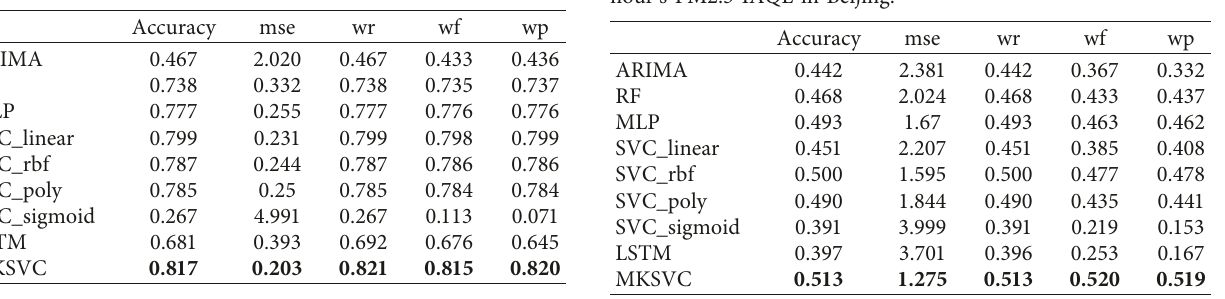
Table 10: Performance comparison for predicting the future 9 hour’s AQHI in HK.